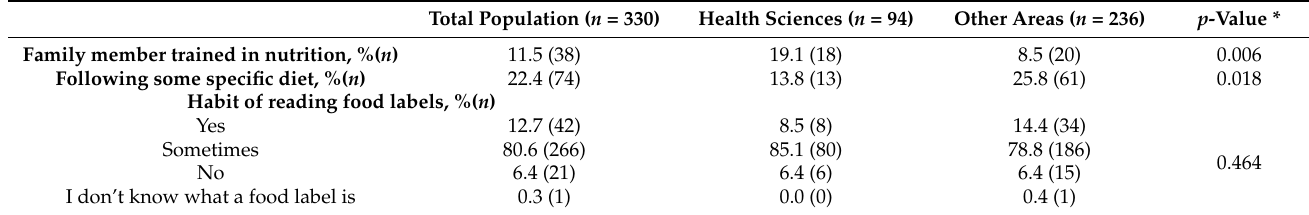
Table 2. Food-related characteristics according to the professional